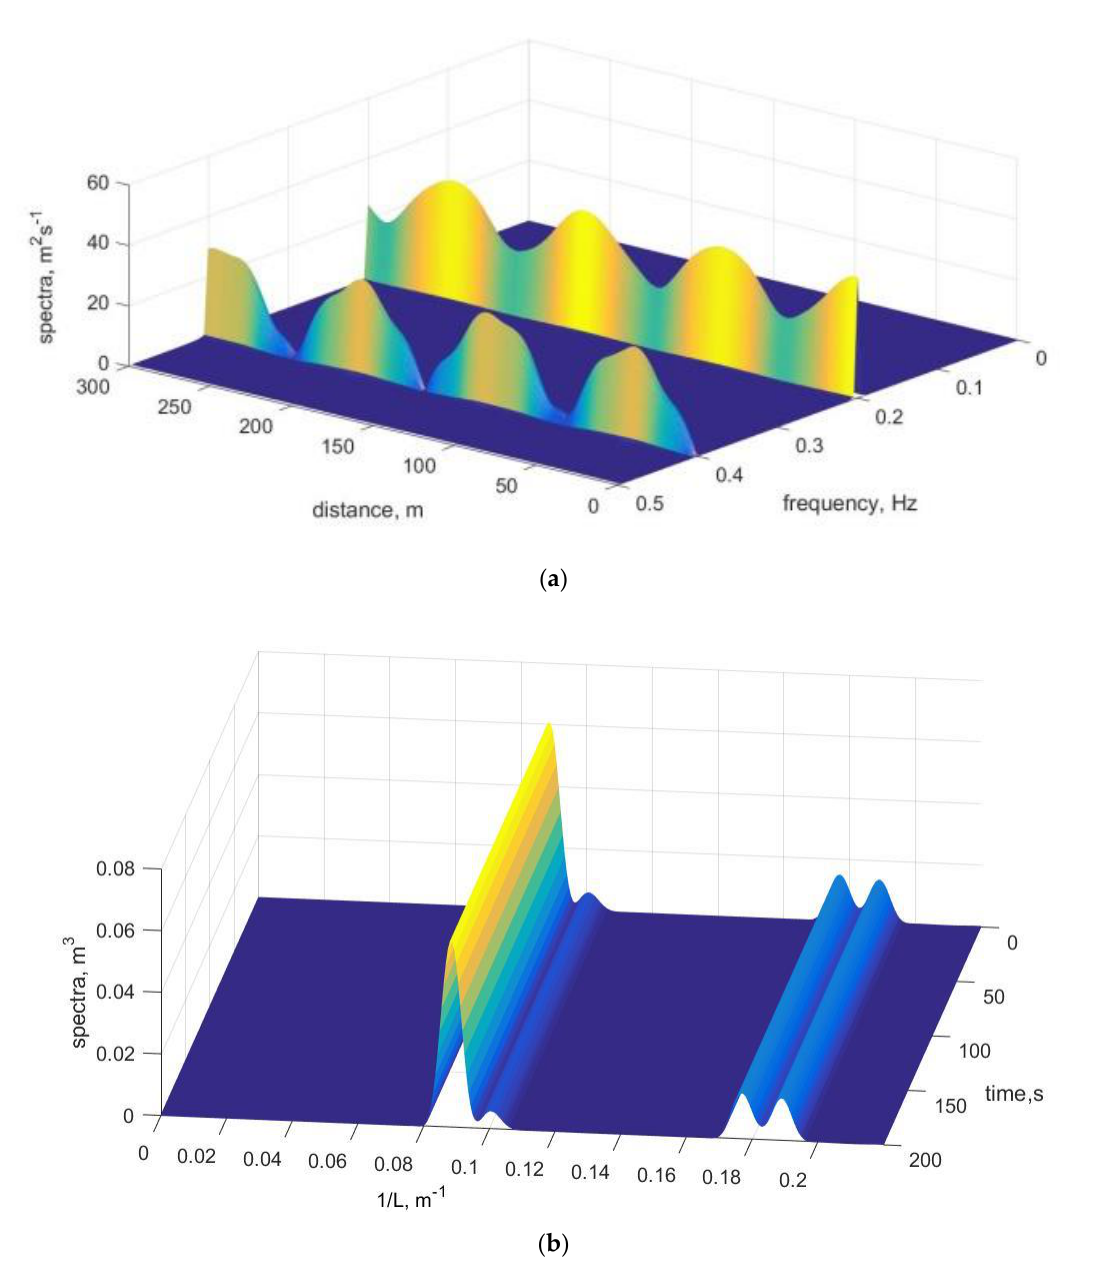
Figure 5. Frequency ( a ) and wavenumber spectra ( b ) of model monochromatic wave propagated over constant depth of 0.5 m. Table 1. Wavenumbers and frequencies of